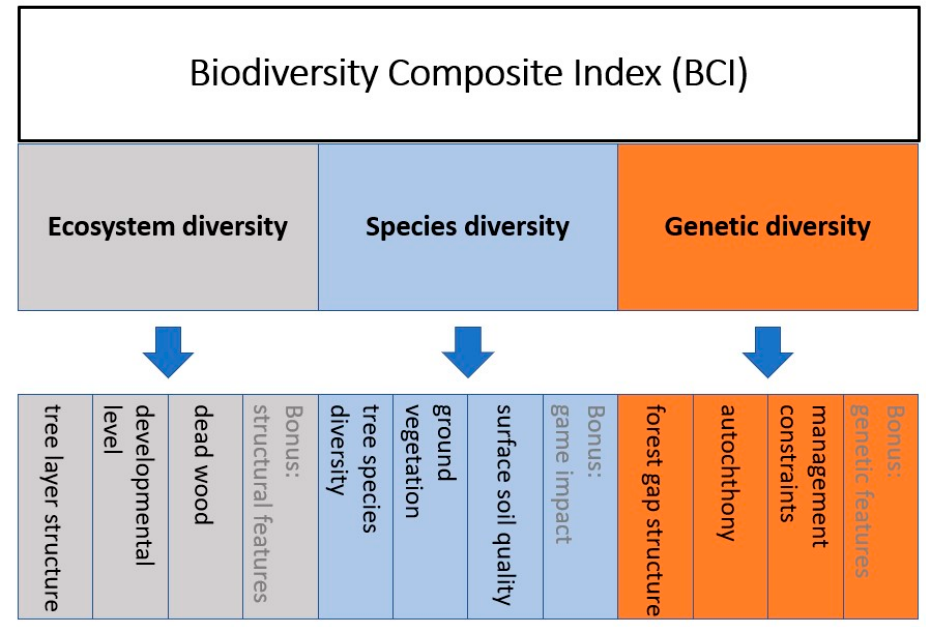
Figure 6. BCI index structure. The modular structure equally considers ecosystem, species, and genetic diversity with three biodiversity indicators (black font color) and one bonus indicator (gray font color), respectively. Indicators are aggregated without weighting. Abbreviations are listed in the Appendix A (Table A1).